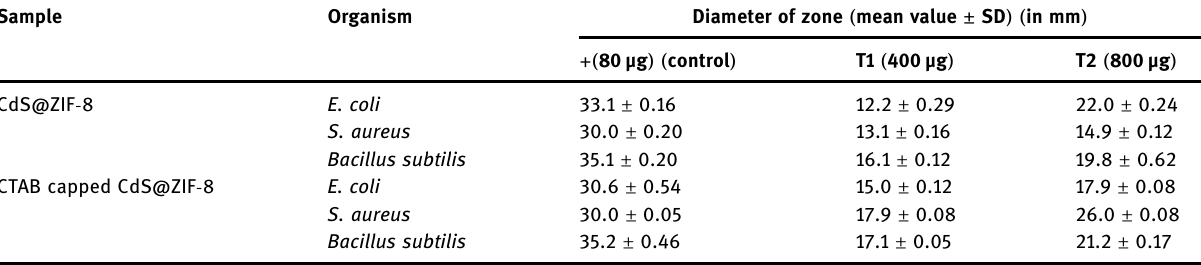
Table 2: Antibacterial activities of CdS@ZIF - 8 and CTAB - capped CdS@ZIF - 8 Sample